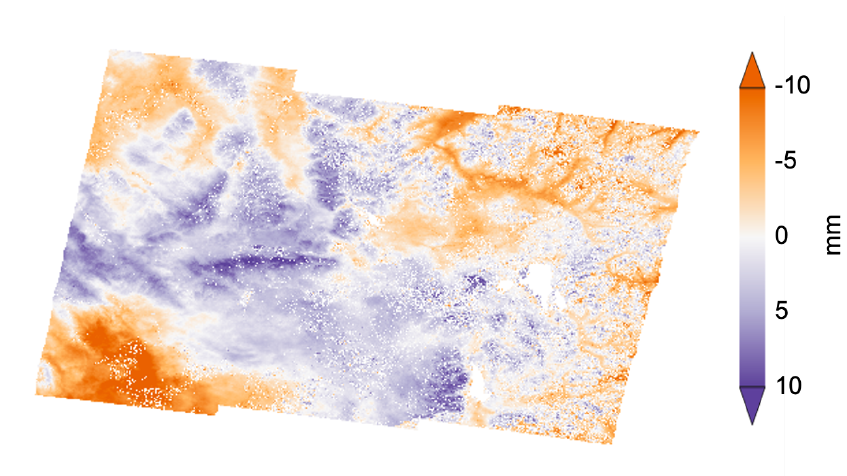
Figure A2. Track 27, Frame 444, 20170816-20171003.